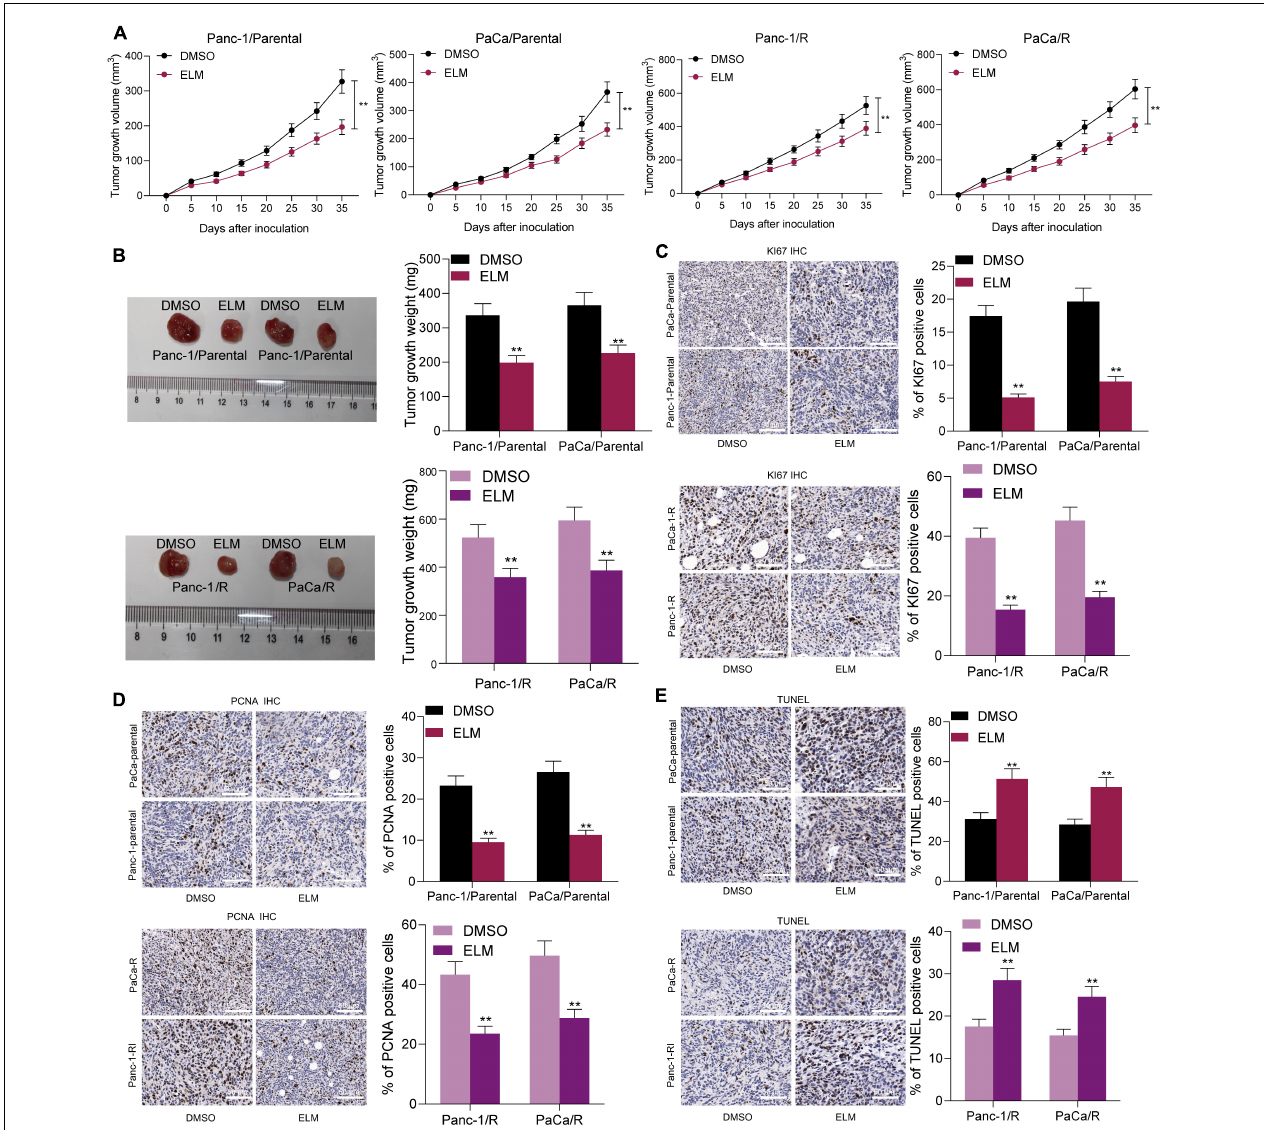
FIGURE 4 | Administration of ELM increases sensitivity of PC cells to genistein. (A) Volume change of the xenograft tumors. (B) Weight of xenograft tumors on the 35th day. (C,D) , Staining intensity of KI67 (C) and PCNA (D) in tumor tissues determined by IHC staining. (E) Cell apoptosis in the tumor tissues measured by TUNEL assay. Data were collected from three independent experiments and presented as mean ± SD. ** p <